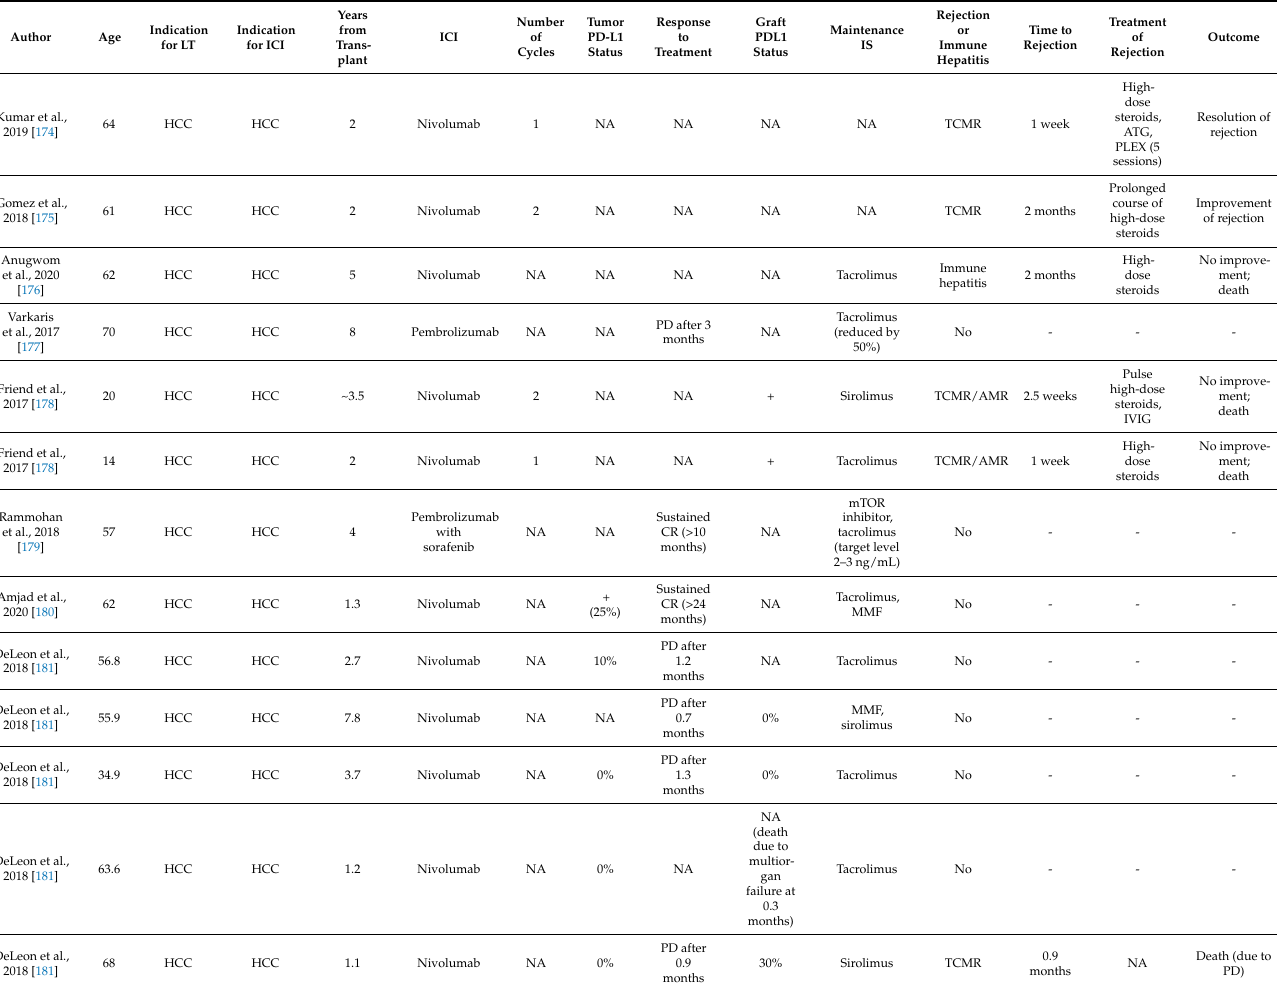
Table 2. Summary of case reports of immunotherapy use following liver